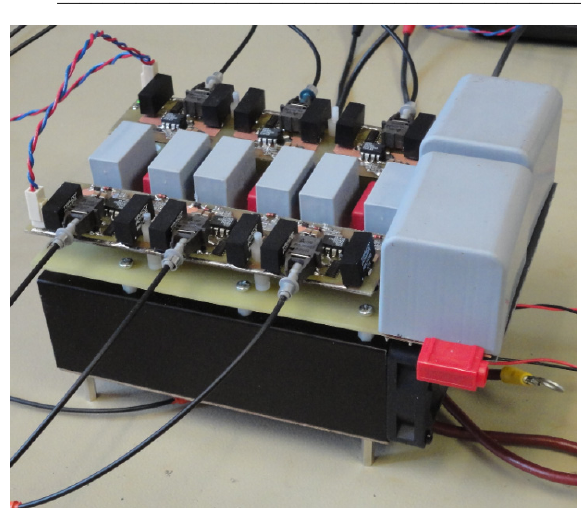
Fig. 9. Developed 14 kVA all SiC AC-DC Grid Connected Converter (GCC) with possibility of short-lived overload up to 28 kVA.